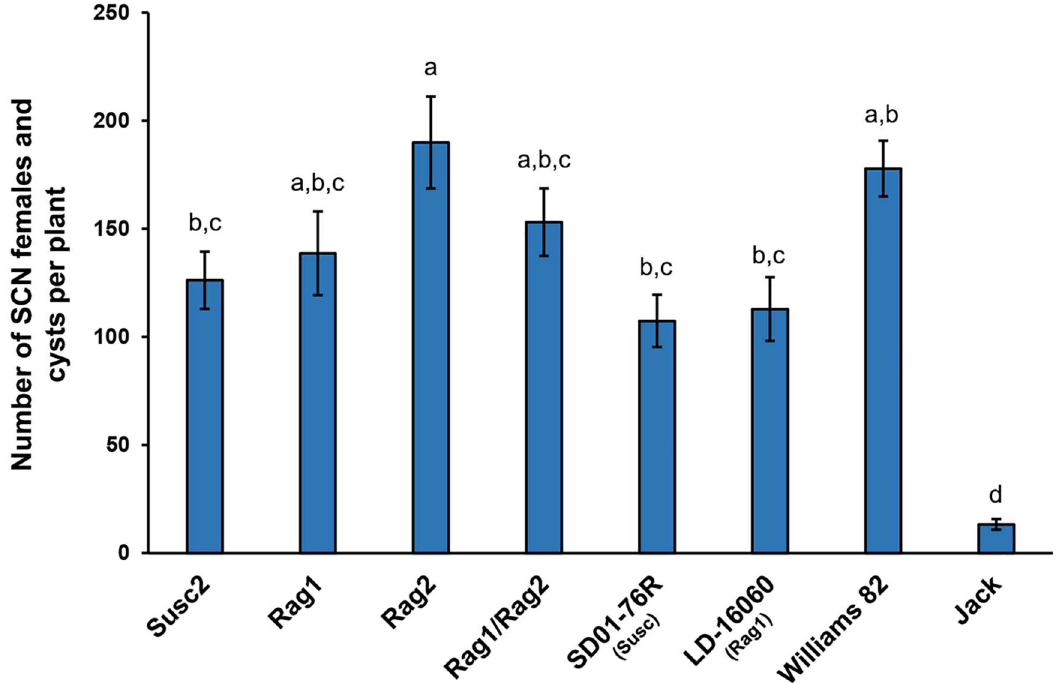
Fig 4. Rag1 and Rag2 do not provide protection against the Soybean Cyst Nematode (SCN). Aphid-susceptible (SD01-76R, Susc2) and resistant (LD-16060,Rag1, Rag2, Rag1/Rag2) soybean lines, and SCN susceptible(Williams-82) and resistant (Jack) controls were sowed in soil infested with SCN. Plants were collectedafter 30 days, and SCN females and cysts were removedfrom roots and counted. Two independentexperiments with 10 plants per line were carried out. Statistically significantdifferencesare indicatedby different letters abovethe bars (One way ANOVA with Tukey HSD; p < 0.05).Error bars = standarderror.